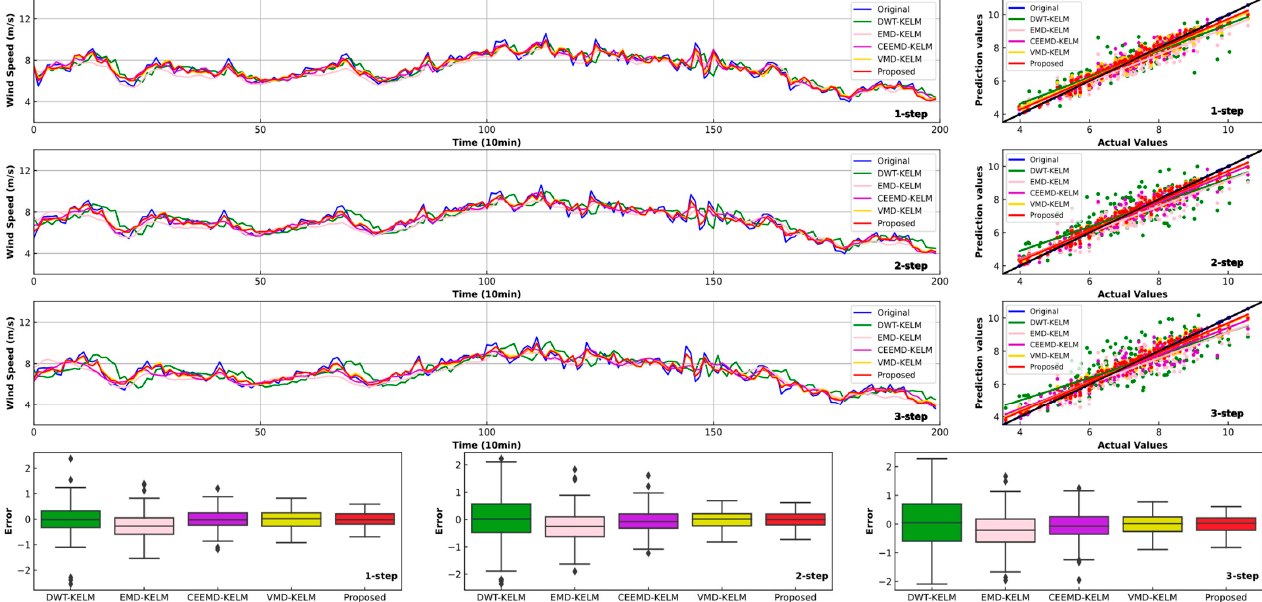
Figure 6. Forecasting performance of decomposed models in one-, two- and three-step ahead forecasting for the summer dataset.